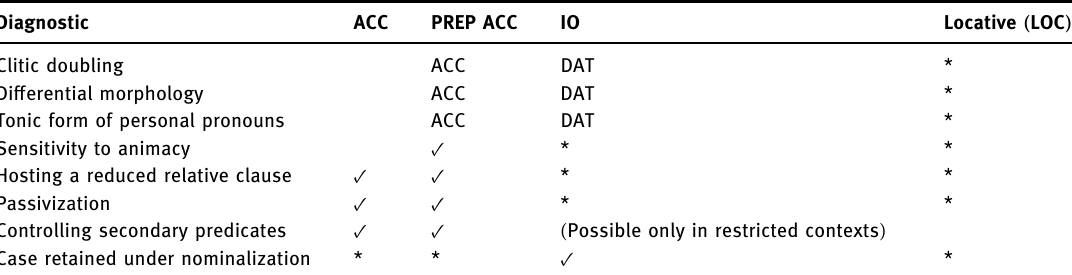
Table 8: Prepositional ACC, IO and LOC in Romanian Diagnostic